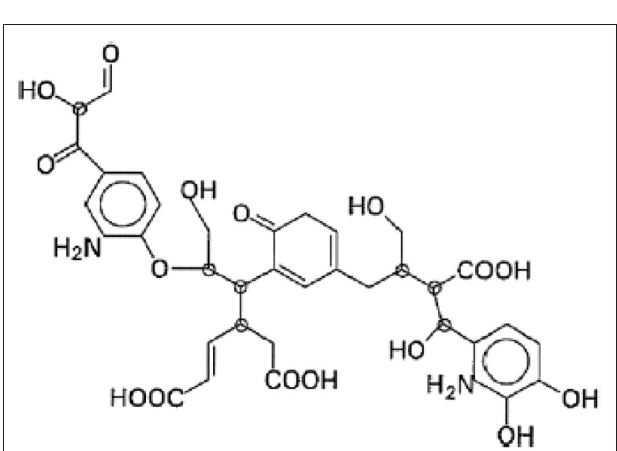
FIGURE 5 | The TNB (Temple–Northeastern–Birmingham) model (Orsi,